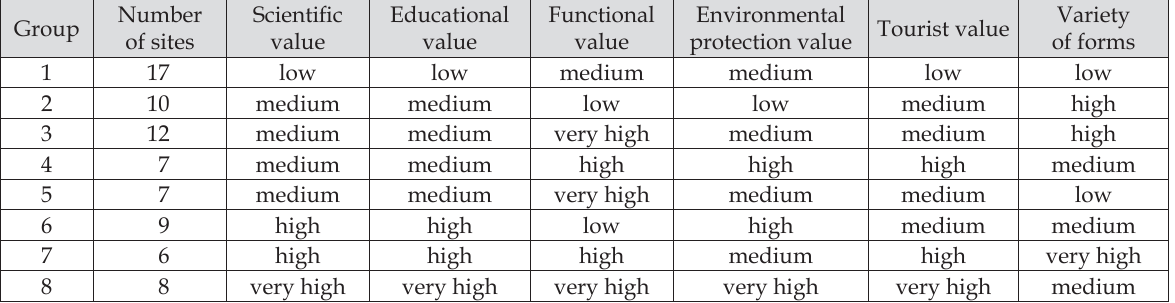
Table 3. Characteristics of the geomorphosite groups